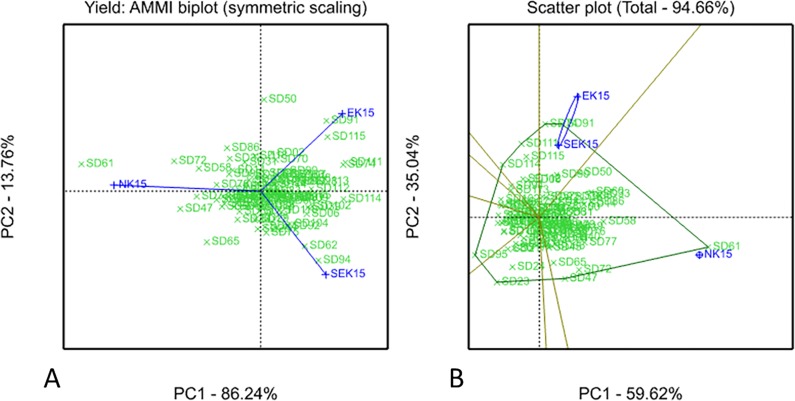
AMMI (A) and Biplot (B) graphics on genotype–environment interaction studies. Analyses based on yield data of soybean collection grown in South-east Kazakhstan (SEK15), East-Kazakhstan (EK15), and Northern Kazakhstan (NK15) harvested in 2015. PC1 and PC2 are Principal Coordinates of the analyses. Environment and genotype scores are given in blue and green colors, respectively.